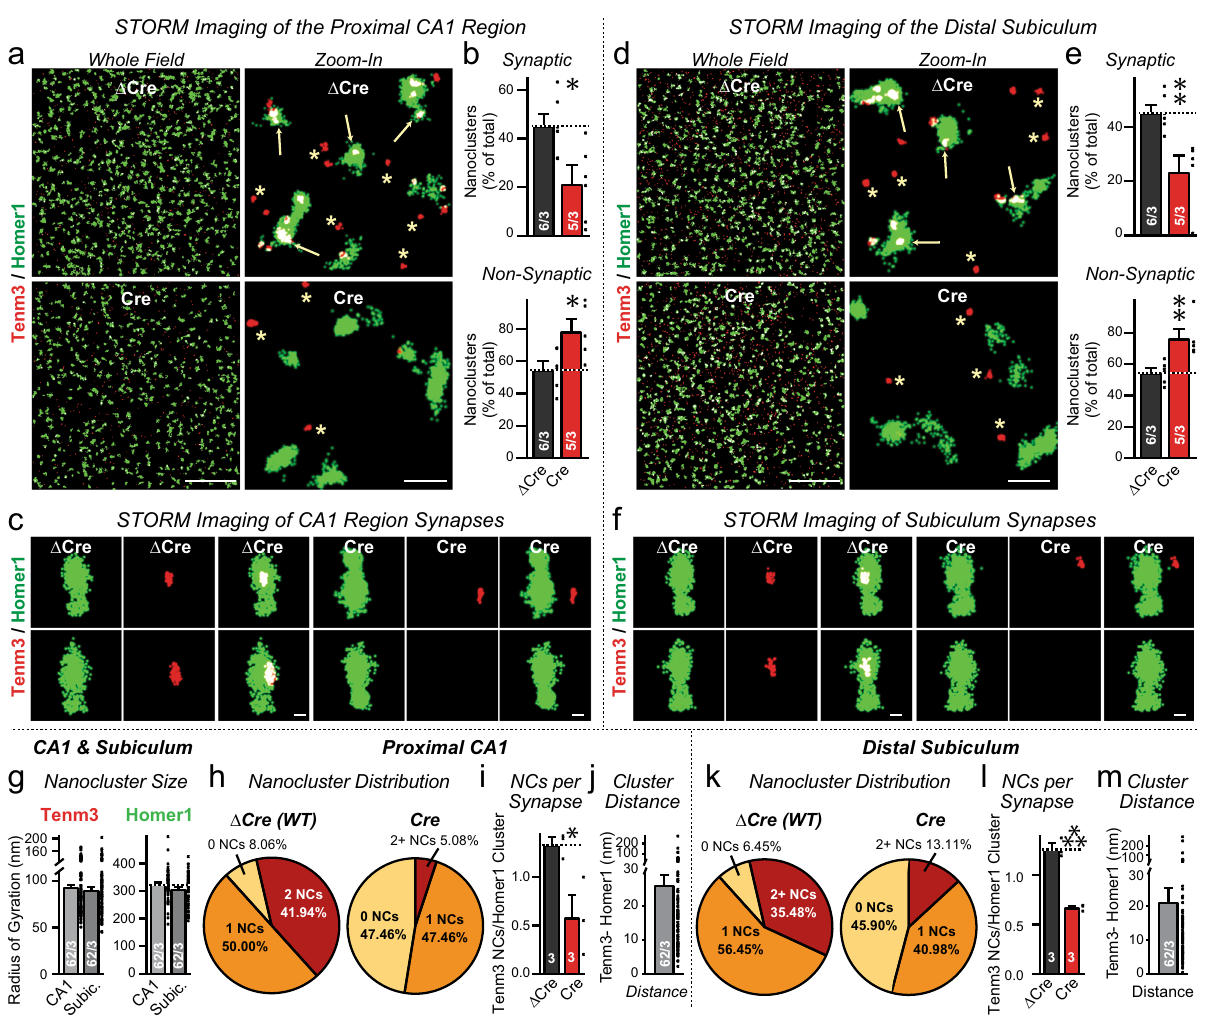
Fig. 3 Super-resolution STORM imaging uncovers Tenm3 nanoclusters adjacent to postsynaptic densities that are visualized using staining for the postsynaptic marker Homer1. a Representative images of Tenm3 nanoclusters (red) and Homer1 (green) visualized using direct stochastic optical reconstruction microscopy in the whole fi eld (left) and zoon-in fi eld (right) at proximal CA1. Brain sections stained include Tenm3 WT (top) and neuron cKO (bottom) at P13, showing multiple Homer1-positive synapses contain Tenm3 nanoclusters. Arrows indicate Tenm3 nanoclusters overlap with Homer1- positive synapses (synaptic Tenm3 nanoclusters). Asterisks represent Tenm3 nanoclusters that are not close to Homer1-positive synapses (non-synaptic Tenm3 nanoclusters). b Summary graph of the percent of Tenm3 nanoclusters close to Homer1 macroclusters from the whole fi eld imaging in Tenm3 WT (top) and neuron cKO (bottom) brain sections. The percent of synaptic Tenm3 nanoclusters was decreased in neuron cKO brain sections in proximal CA1. c Representative images of individual synapses from proximal CA1 with Tenm3 WT (left) and neuron cKO (right) showing Homer1-positive synapses with Tenm3 nanoclusters. d – f Same as a – c , except that brain sections were analyzed from distal subiculum. The percent of synaptic Tenm3 nanoclusters was decreased in neuron cKO brain sections in distal subiculum. g Tenm3 nanoclusters and Homer1 macroclusters size measured as the radius of gyration. h Pie charts showing the distribution of Homer1-positive excitatory synapse without or with Tenm3 nanoclusters (i.e., 1 and 2 + ) in Tenm3 WT (left) and neuron cKO (right) in proximal CA1. i Summary graph of the average number of nanoclusters per Homer1-positive excitatory synapse in Tenm3 WT and neuron cKO from proximal CA1. j . The minimum intercluster distance between Homer1 and Tenm3 clusters. k – m Same as h – j , except that brain sections were analyzed from distal subiculum. Bar graphs show means± SEM; numbers of sections/mice are indicated in the bars. Statistical signi fi cance was assessed using two-sided Student ’ s t-test (* p < 0.05; ** p < 0.01). For additional experiments and quanti fi cations, see Supplementary Fig. 2. Scale bars: 10 µ m ( a , d , left panel), 1 µ m ( a , d , right panel) and 200 nm ( c , f